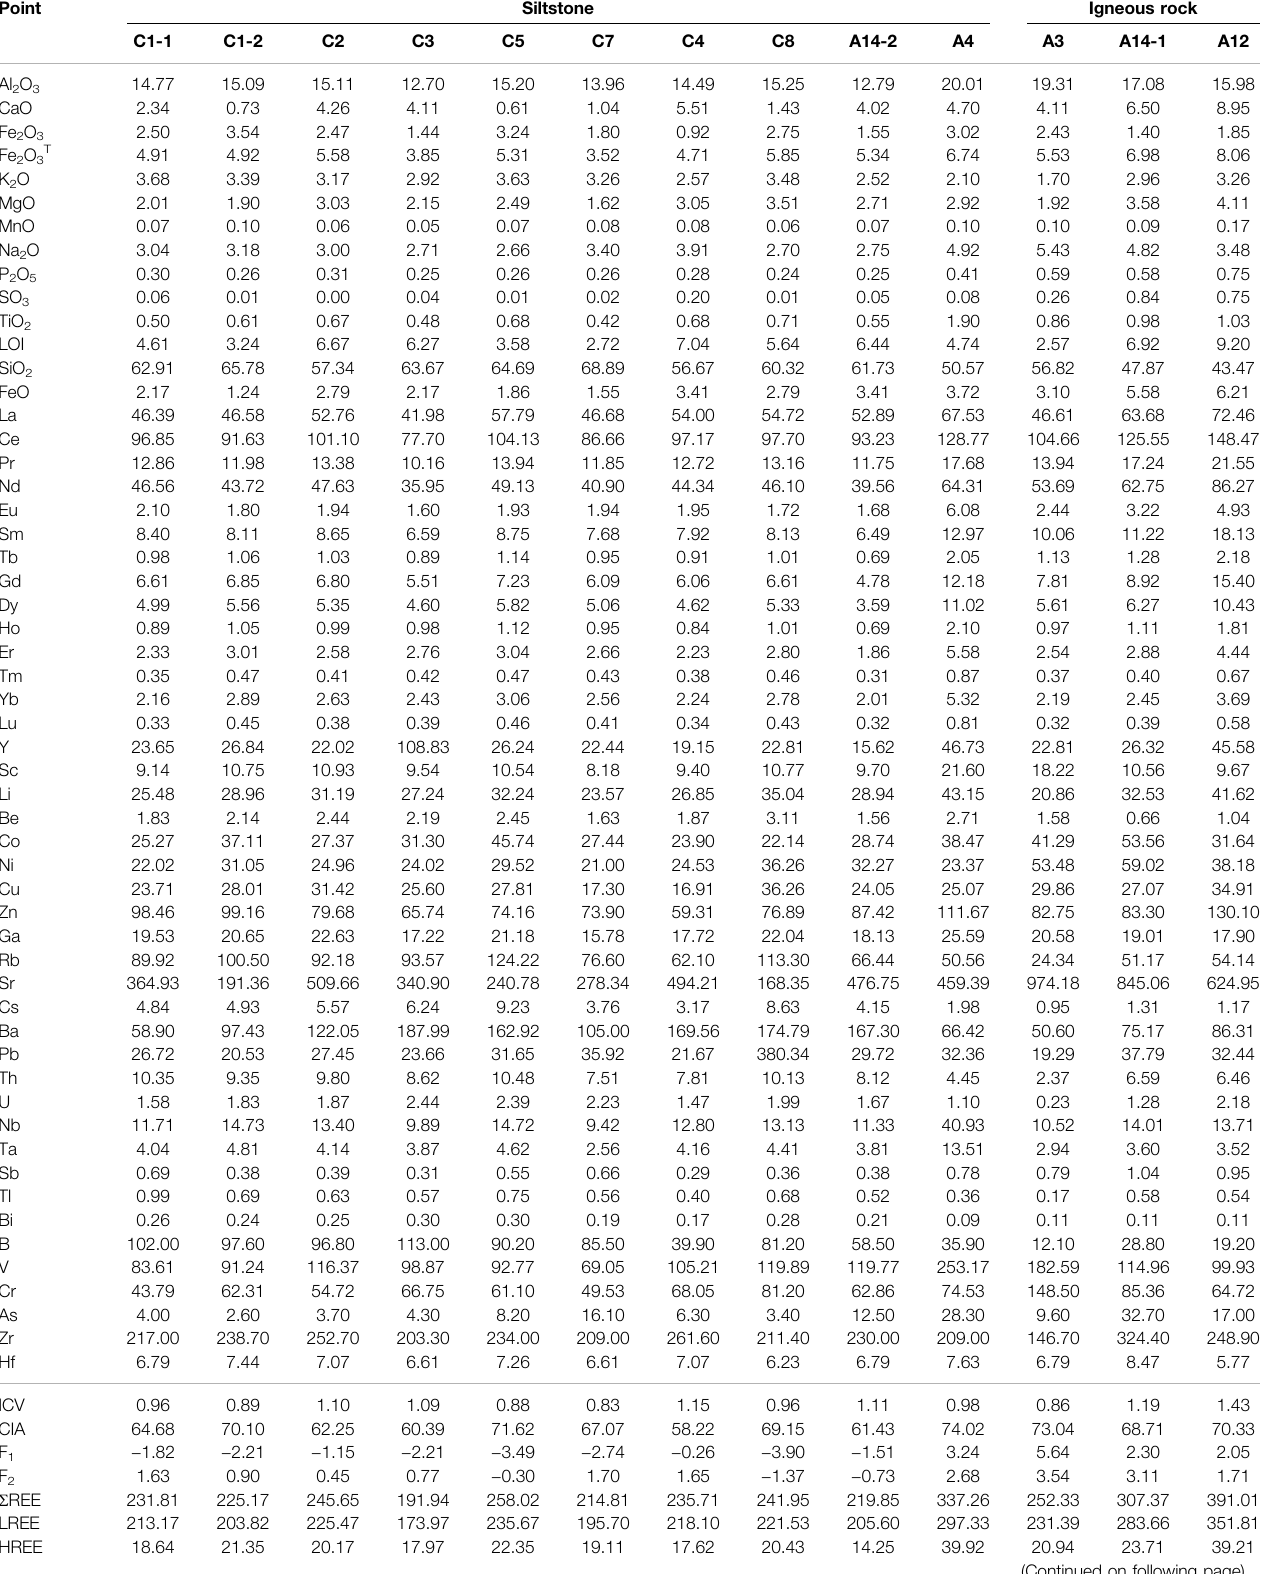
TABLE 1 | Main elements (%), trace elements, REE (PPM), and characteristic values of samples in the Laohuzui section. Point Siltstone Igneous rock